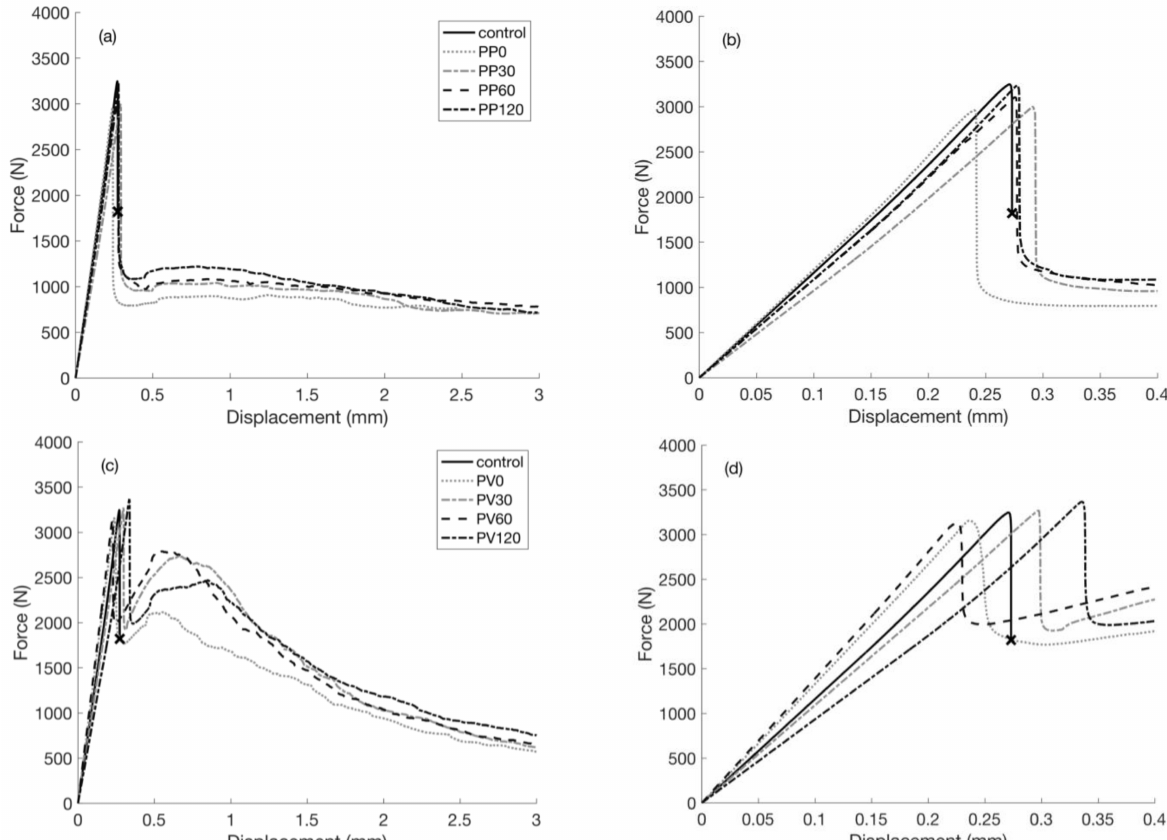
Figure 7. Force–displacement plots for PP ( a , b ) and PV fiber specimens ( c , d ) with different fiber treatment times tested in